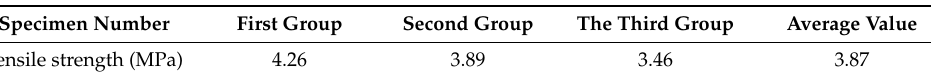
Table 3. Tensile test results of ECC specimens.